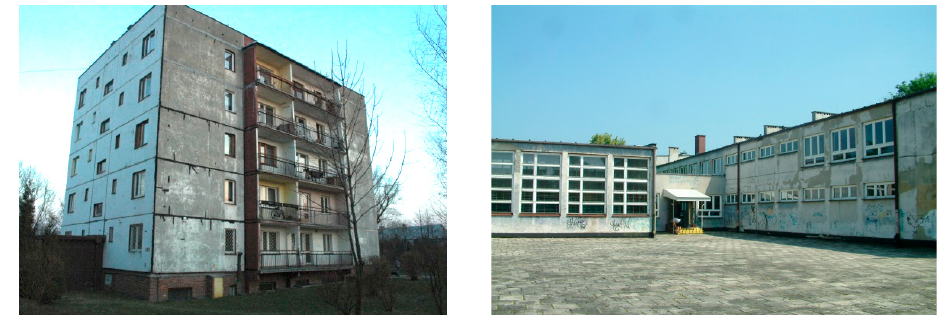
Figure 1. Views of the buildings that were chosen to be researched: A multifamily residential building (on the left ) and a school building (on the right